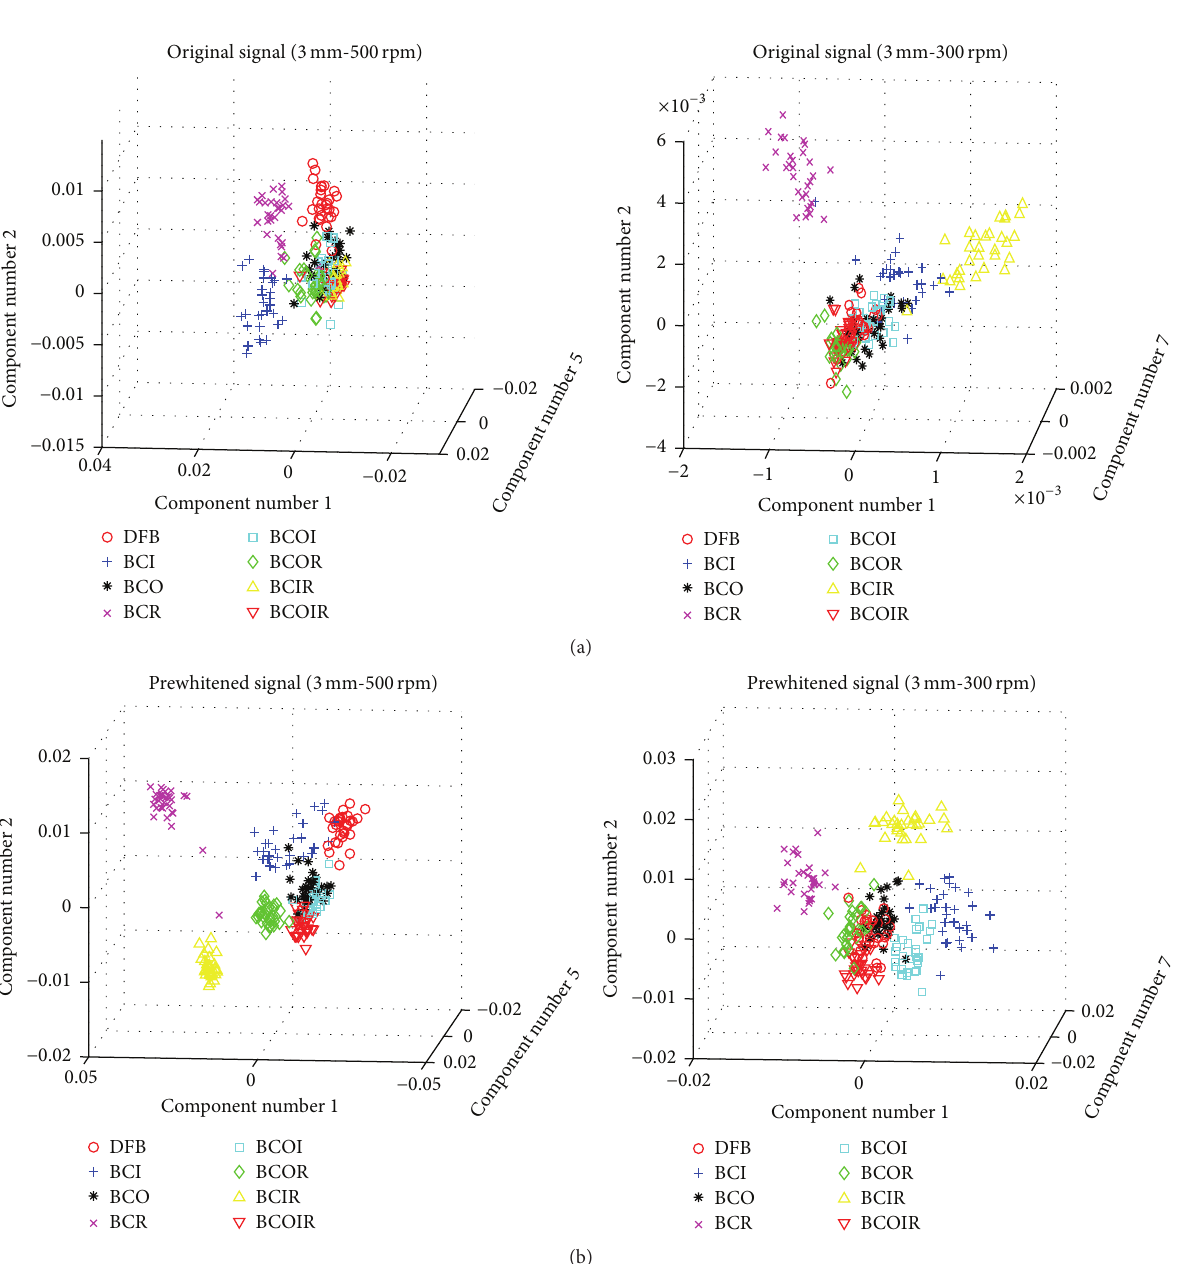
improve the classification performance of our